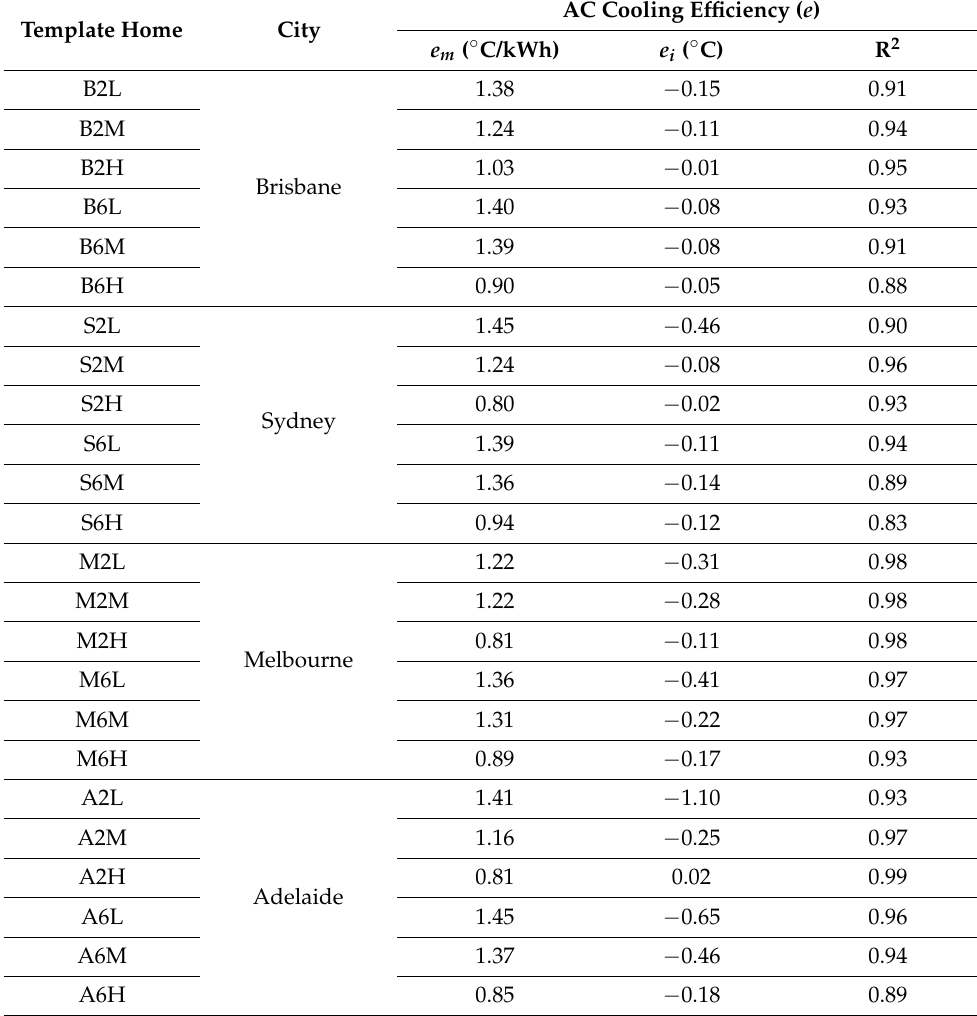
Table A2. AC cooling efficiencies.